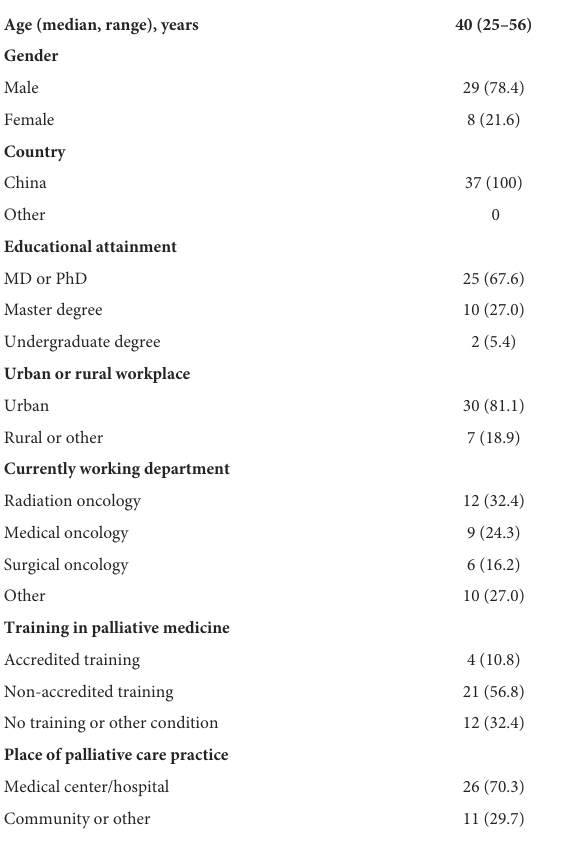
TABLE 1 Demographic characteristics of survey participants ( n =